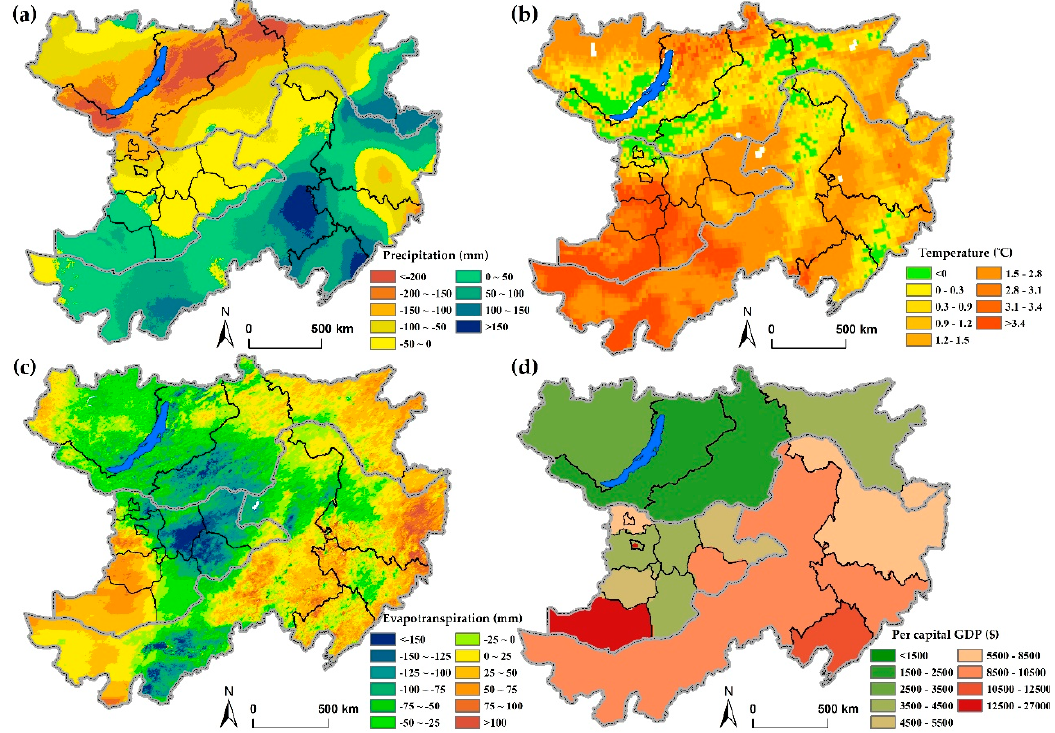
Figure 8. Change trends of annual total precipitation ( a ), average temperature ( b ), and annual total evapotranspiration ( c ), and per capita GDP ( d ) in the CMREC area between 2000 and 2015.